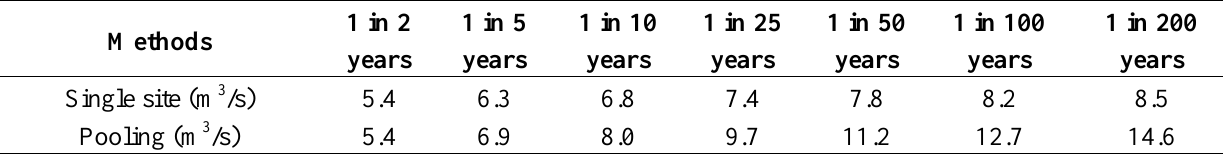
Table 1. Flood discharge estimates for different return periods.